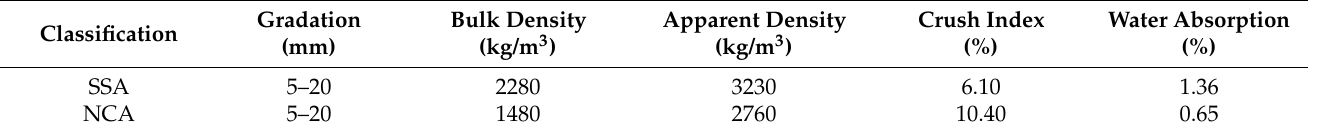
Figure 1. The graining curves for SSA and NCA. Table 1. The material performance of coarse